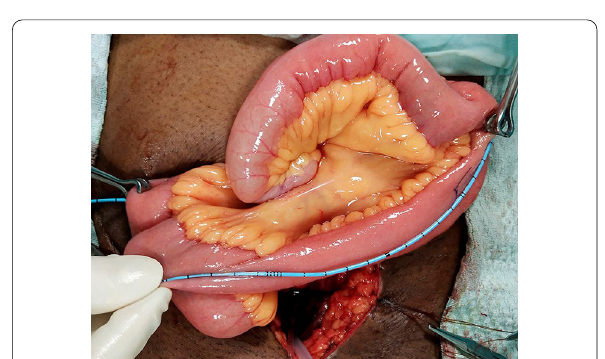
Fig. 8 Augmentation using ileum